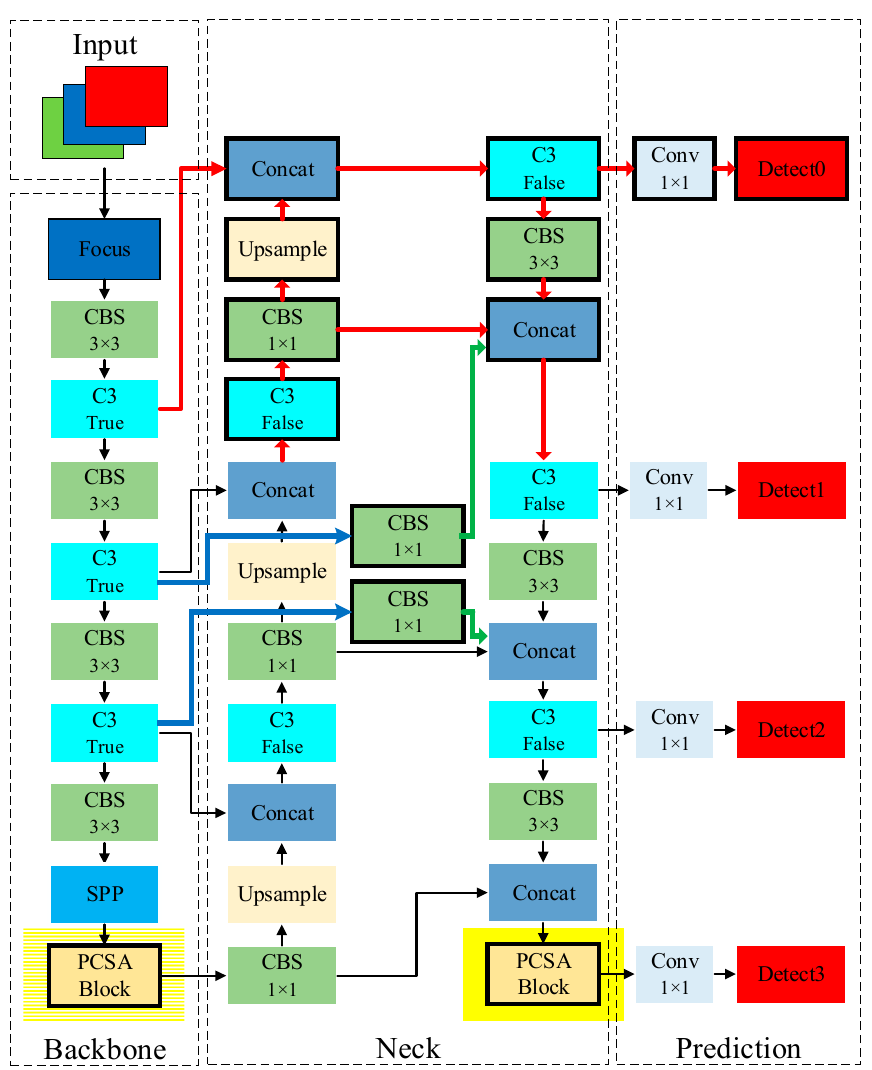
Figure 2. Optimiz e d YOLOv5s structure. Figure 2. Optimized YOLOv5s